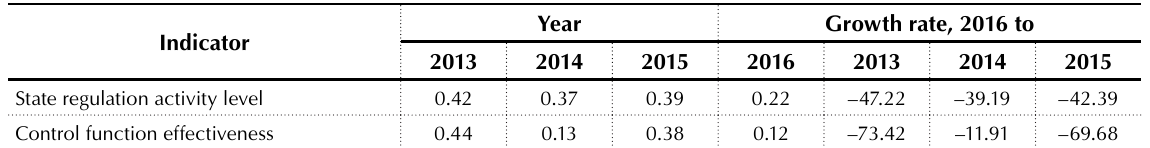
Table 3. Analysis of the state regulation activity of the Ukrainian FSMs and the effectiveness of the control function implementation in